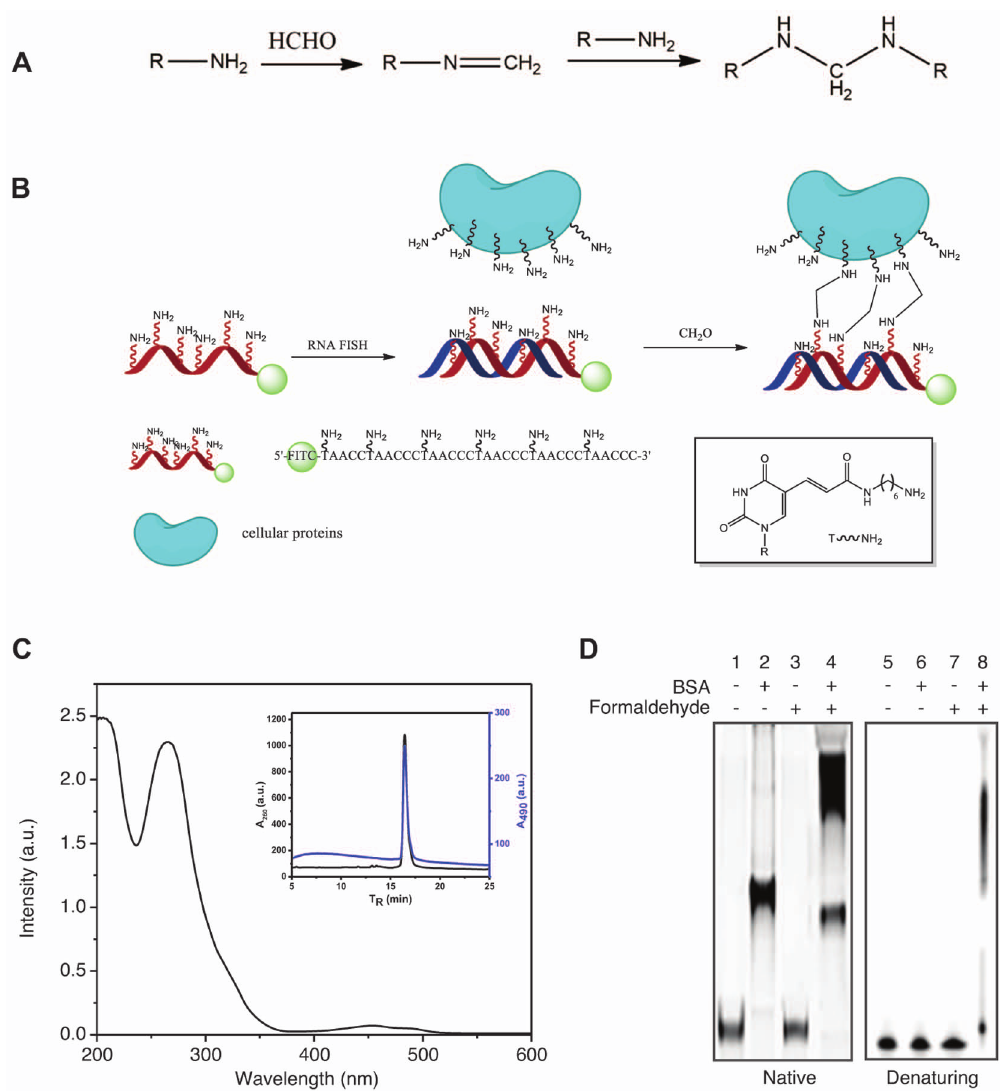
Figure 1. Scheme of amino-labeled DNA probes for formaldehyde fixation. (A) Chemical reactions of formaldehyde fixation. (B) Scheme of formaldehyde mediated crosslink between amino-labeled probe and cellular proteins in vicinity. (C) UV-vis absorption spectra of the oligonucleotide probe. Insert : HPLC purification trace of amino-labeled probes. (D) Electrophoretic mobility shift assay (EMSA) of formaldehyde mediated crosslink between the oligonucleotide probes and bovine serum albumin (BSA) on native (Lane 1 to 4) and denaturing PAGE (Lane 5 to 8).